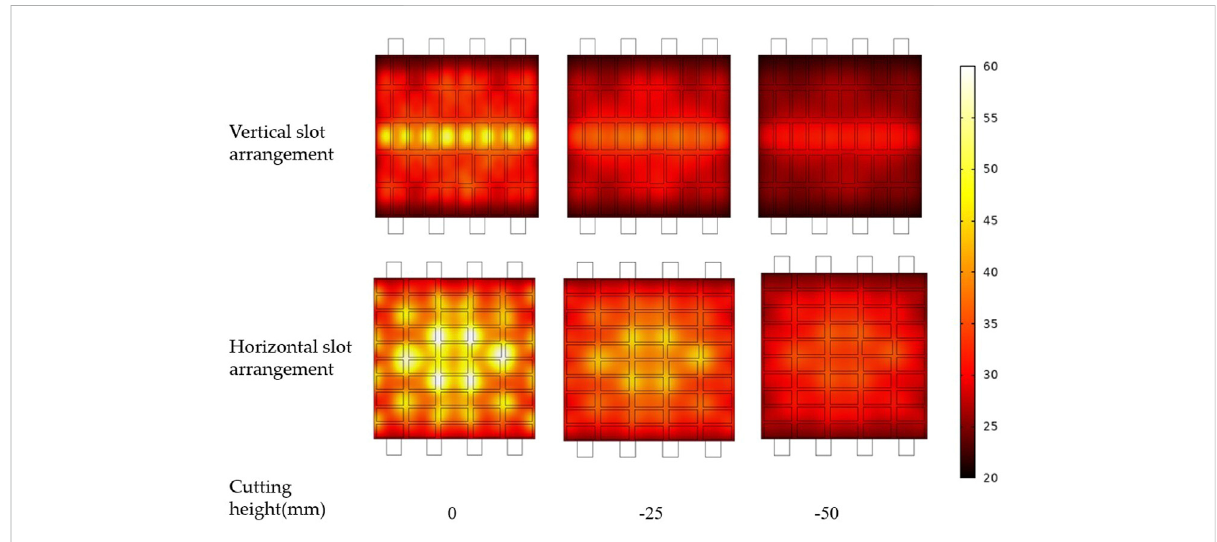
FIGURE 4 Temperature distribution in the cross section of heat absorbing material for vertical and horizontal slot arrangement.